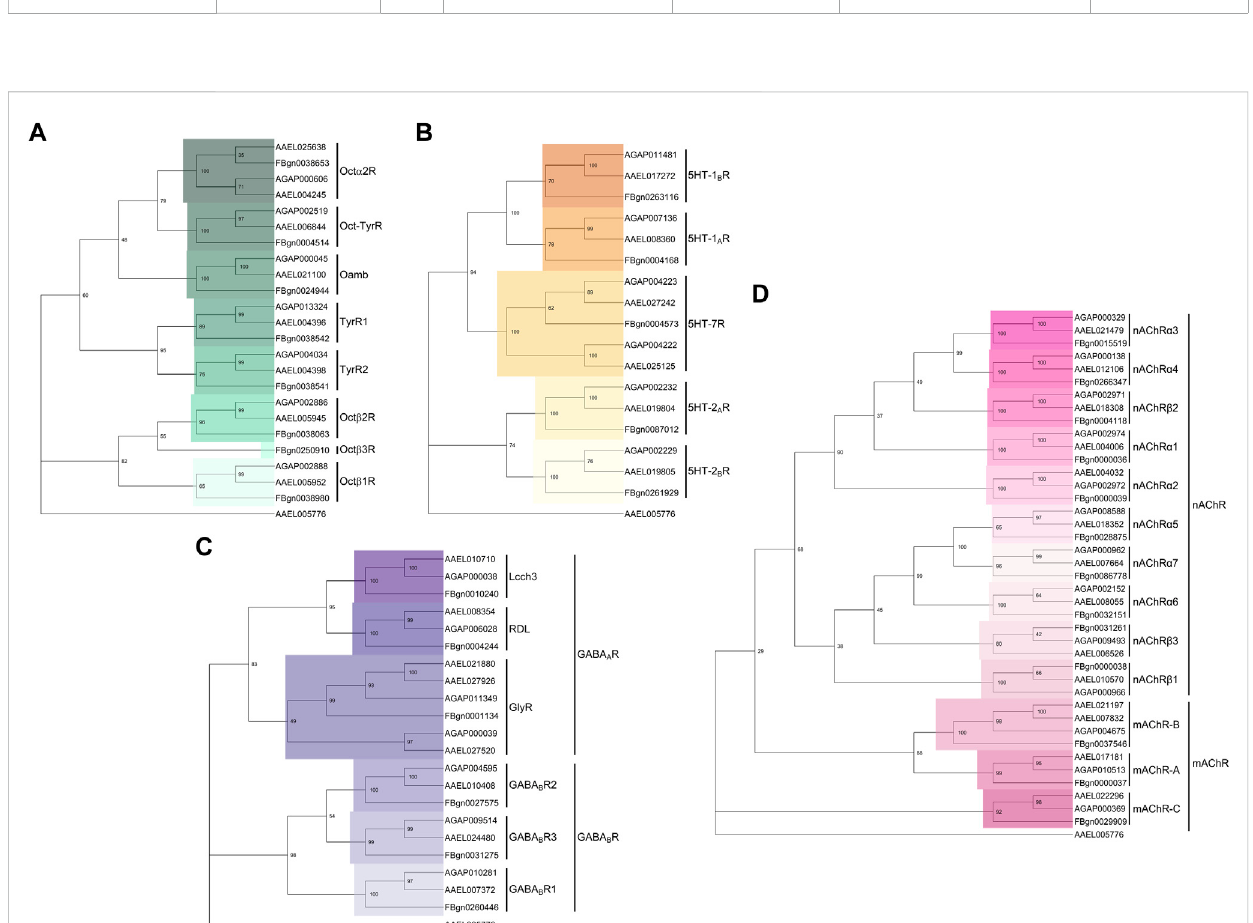
FIGURE 5 Phylogenetic trees of neurotransmitter receptors across Dipteran species. (A – D) Phylogenetic trees built from the protein sequence alignment for (A) octopamine, (B) serotonin, (C) GABA and (D) acetylcholine receptor subunits in An. gambiae , Ae. aegypti and D. melanogaster . Using MEGA (software version 11), protein sequences were fi rst aligned using MUltiple Sequence Comparison by Log- Expectation (MUSCLE), aligned sequences were then subjected to 1000-fold bootstrapping to build the phylogenetic tree for each neurotransmitter receptor family. The Ae. aegypti odorant receptor obligate co-receptor Orco (AAEL005776) was selected as an outgroup